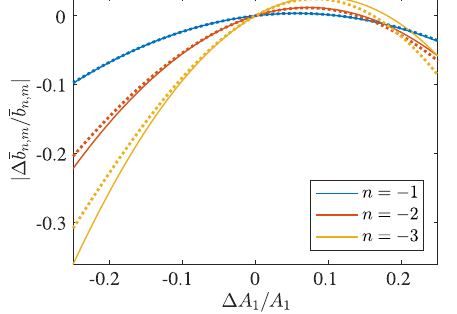
FIG. 3. Variation of bunching with deviations in A 1 from that used to calculate Eq. (4). A 1 ¼ 5 is assumed. Solid lines are from Eq. (9), dashed lines are from exact solutions.